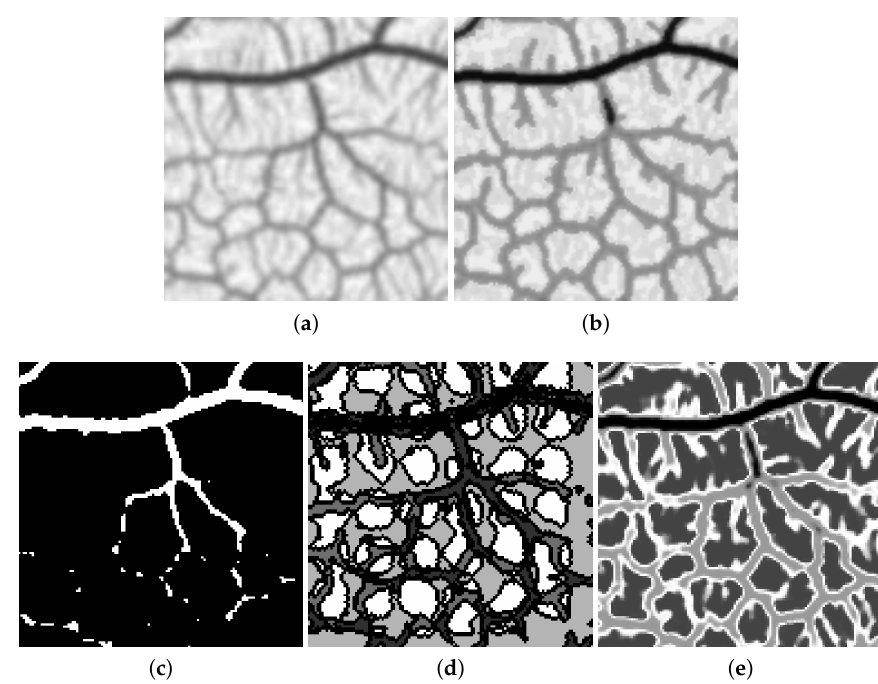
Figure 5. Segmentation of the ‘Leaf’ image: ( a ) the original image; the segmented outputs of ( b ) the proposed method, ( c ) graph cut method, ( d ) Vese–Chan and ( e ) fuzzy segmentation methods.